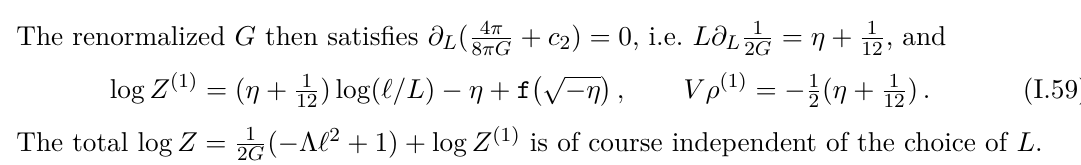
Figure 23 . Edge contributions to the dS 4 entropy from massive spin s = 1 , 2 , 3 fields, as a function of m‘ , with coloring as in figure 21. The Higuchi/unitarity bound in this case is 0 ( m‘ ) 2 − ( s − 1 ) 2 > − 1 0 2 4